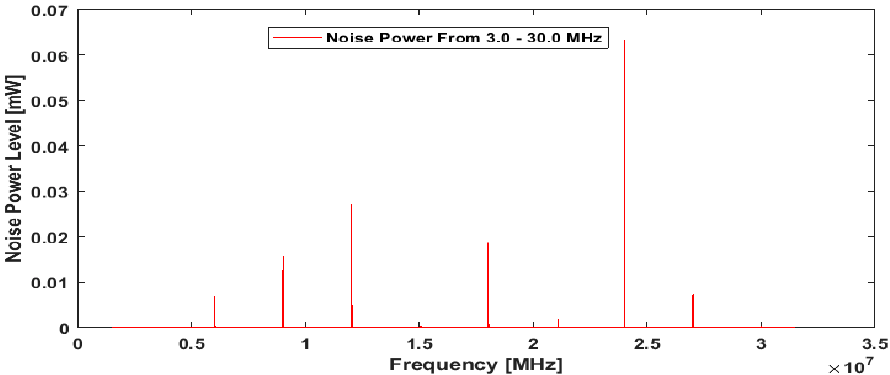
Figure 8. Electric Kettle observed noise power from 3 MHz to 30 MHz.